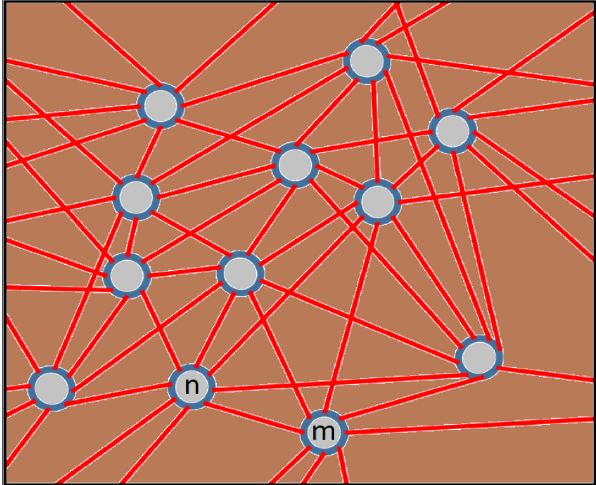
Figure 3. A visual representation of the graph that represents the simulated